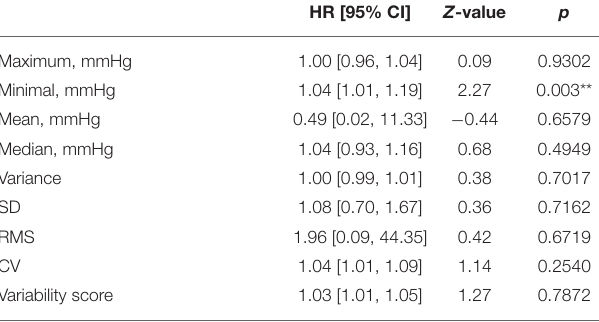
TABLE 3 | Multivariate Cox regression analysis to predict incident